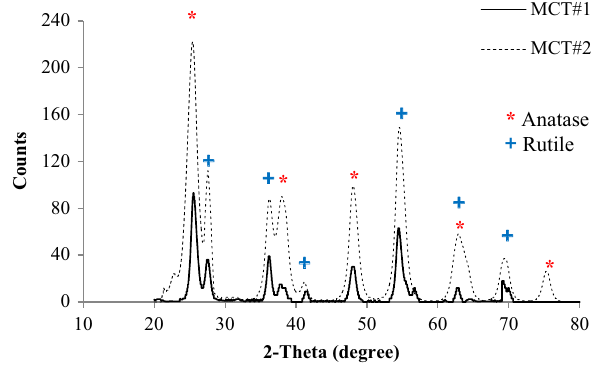
Fig. 5 Changes in MO destruction with irradiation time and pH in the suspension containing MCT#2 as